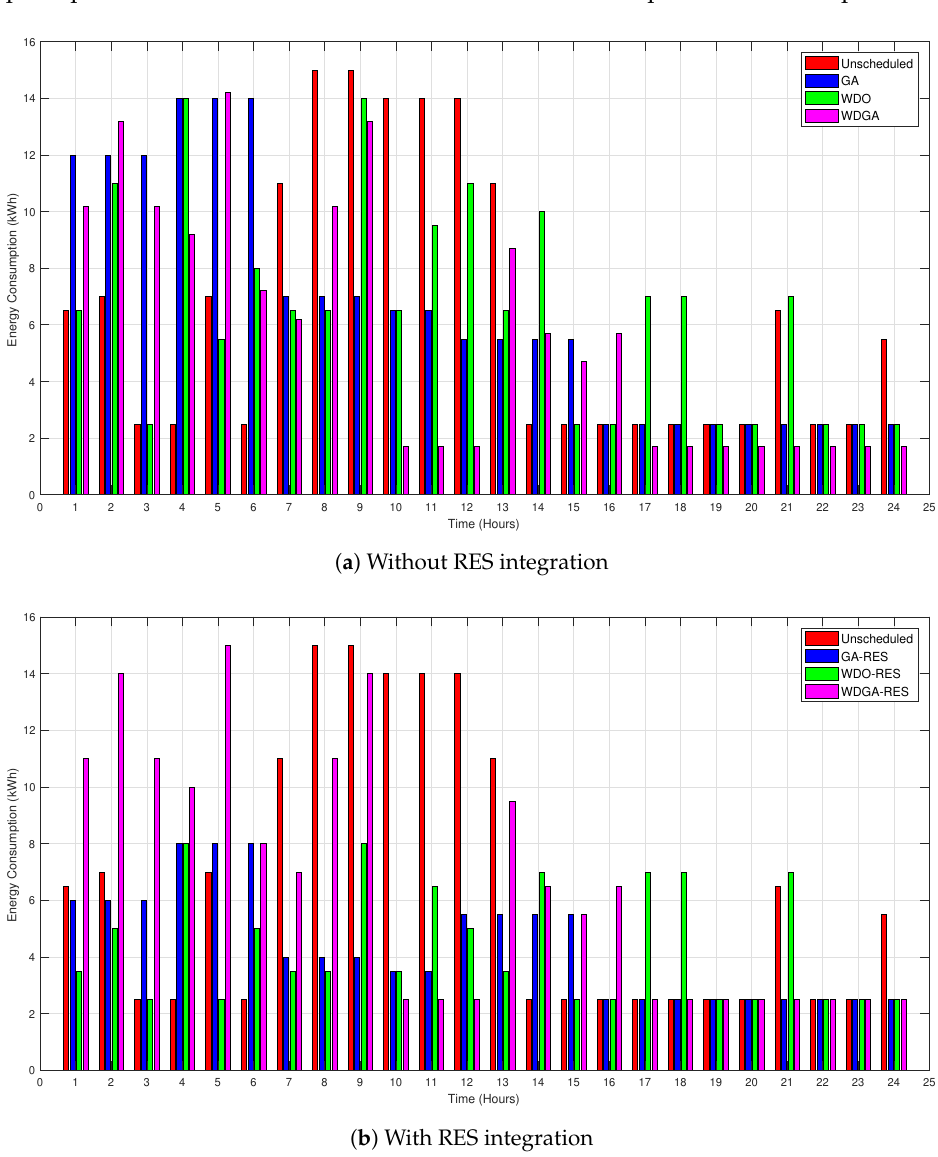
Figure 4. Energy consumption profile by